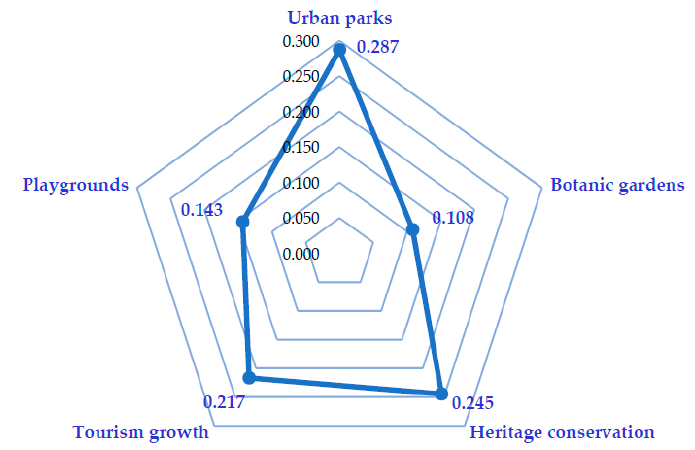
Figure 14. Relative weights of the assessment indicators for “Urban Spaces and Tourism”.